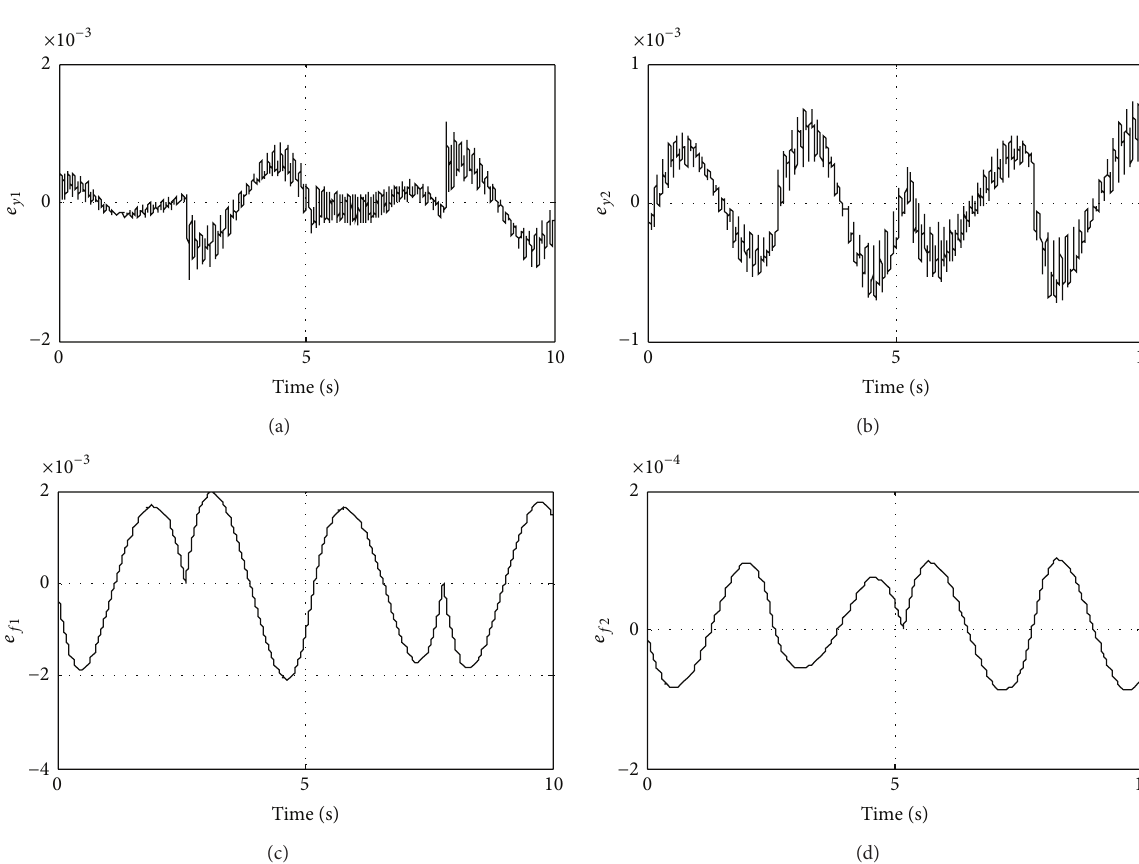
the flexible part (69) take the same form as the one obtained in